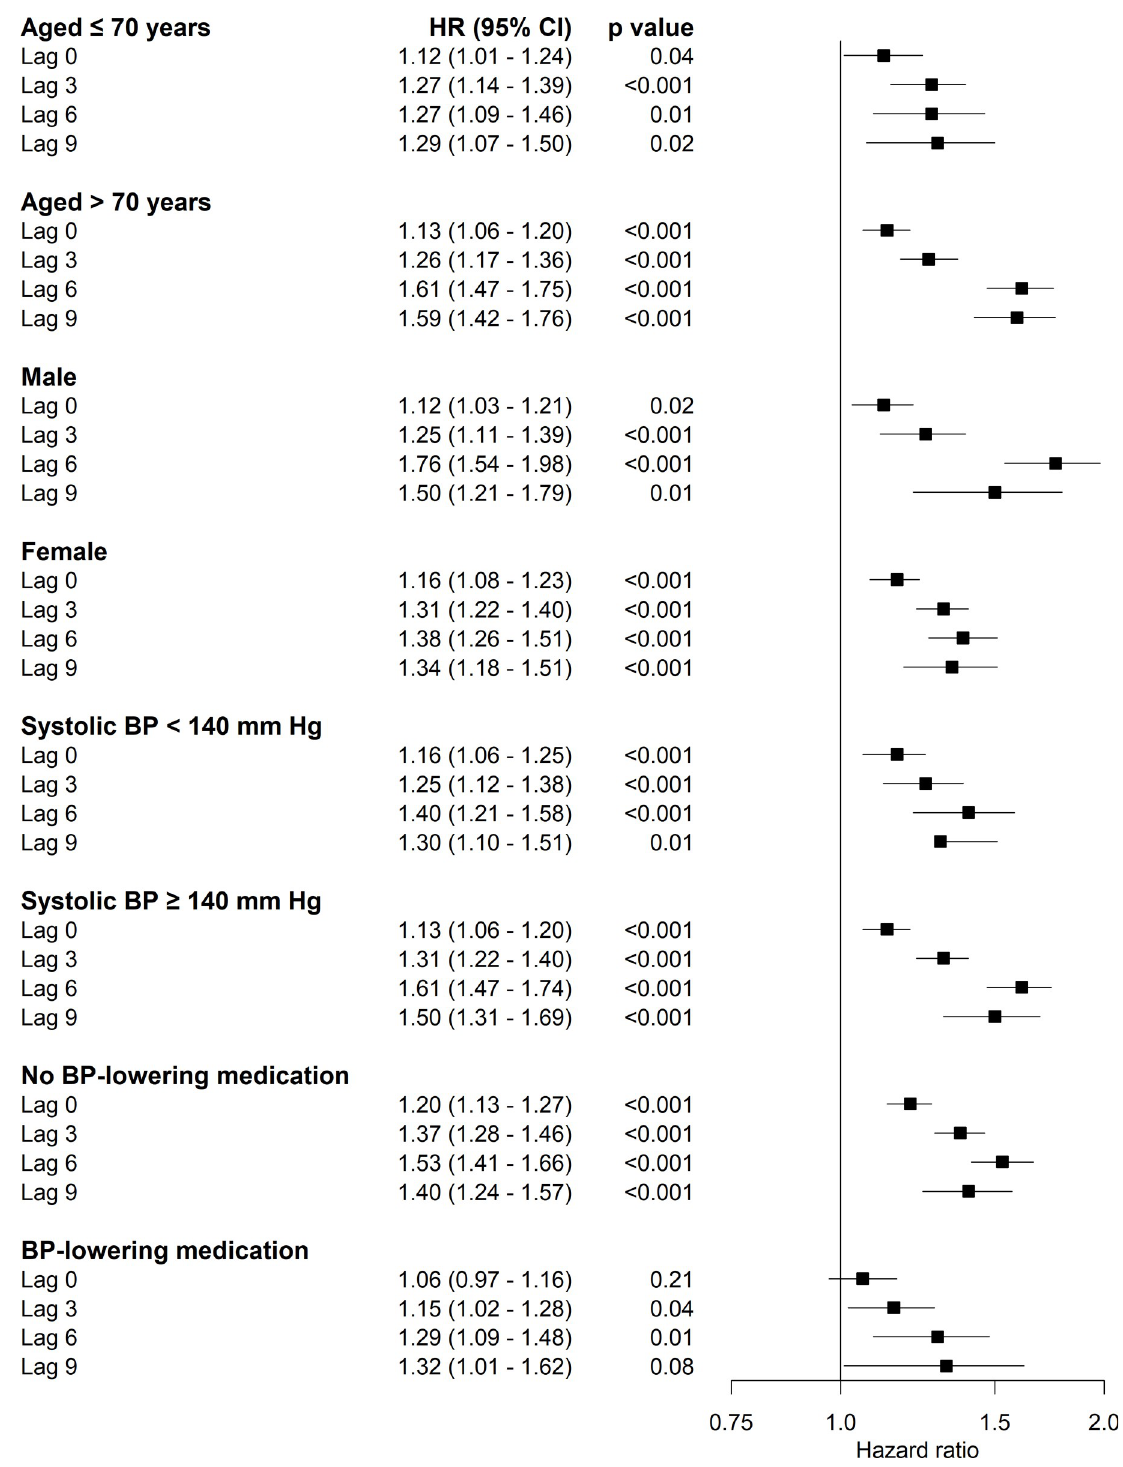
Fig 3. Stratified analyses of the association between systolic blood pressure (BP) variability and incident any stroke using different lag periods. The black squares represent the hazard ratio (HR) of incident any stroke per SD increase in systolic blood pressure variability. The error bars are the 95% confidence intervals (CIs) around the hazard ratios. The models were adjusted for age, sex, mean systolic blood pressure AU : InthelegendforFig 3 : Inthelistofcovariatesadjustedfor ; Ichangedmeansystolicordiastolicbloodpressuretomeansystolicbloodpressure : Ifthisisnotcorrect ; pleaseeditasnecessary : , and propensity score.